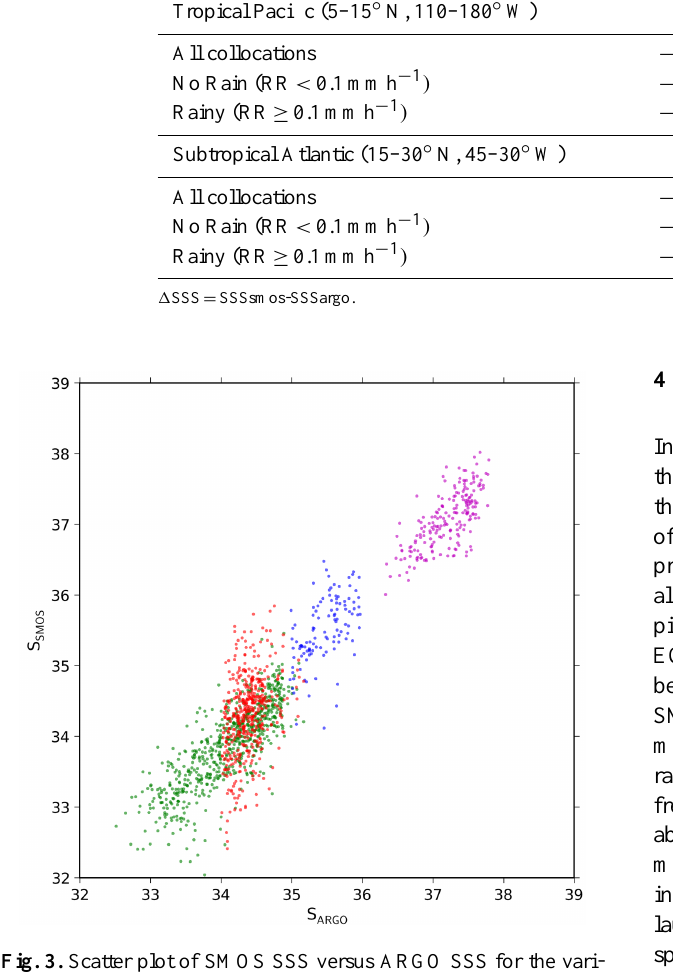
Fig. 3. Scatter plot of SMOS SSS versus ARGO SSS for the vari- ous regions indicated on Fig. 1 and in Table 1 (green: tropical Pa- cific Ocean; purple: subtropical Atlantic Ocean; blue: Soutern In- dian Ocean; red: Southern Pacific